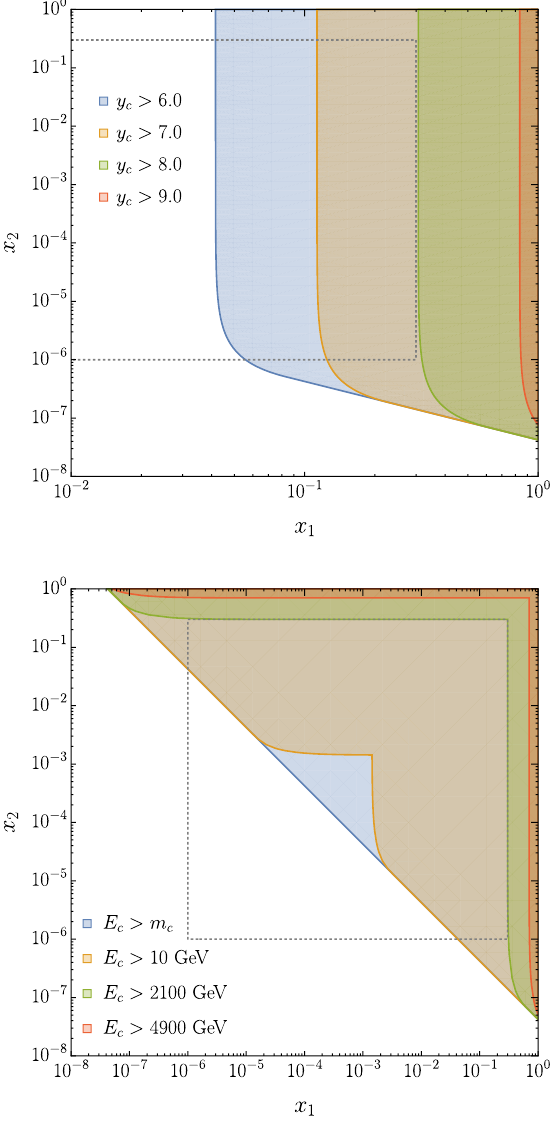
√ Figure 9. For pp → c + X production for s = 14 TeV, the ( x 1 , x 2 ) regions that contribute to charm quark rapidity distributions (upper) for y c > 6 , 7 , 8 , 9 , respectively, where x 1 > x 2 for y c > 0 , and energy distributions (lower) for E c > m c , 10 GeV, 2.1 TeV and 4.9 TeV. See the text for further discussion. In both panels, the colored regions extend to large x 1 , overlapped by regions with further limitations on the y c or E c values. In the lower panel, the shaded regions for E c > m c covers the full upper right triangle. The dotted lines show x i = 10 − 6 and x i = 0 . 3 . Between these values, the PDFs considered in this work are best constrained by data or differ less among each